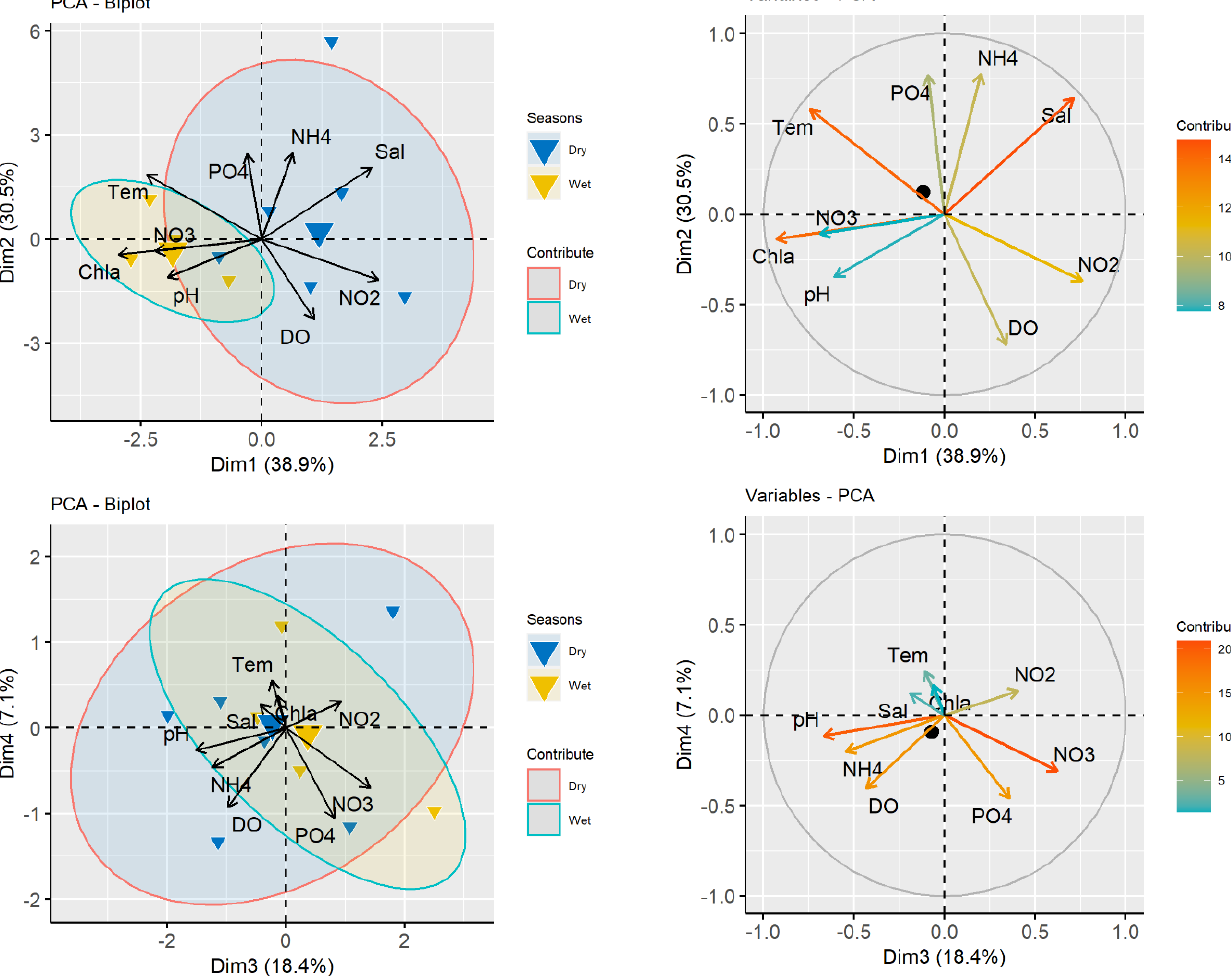
Figure 2. Principal component analysis (PCA) showed that water temperature, salinity and chlorophyll-a had a significant effect on fish distribution and assemblage composition. Cluster analysis grouped the nine water quality parameters (Temperature, NO 3 − , Chl-a, pH, PO 43 − , NH 4+ , salinity, NO 2 − and DO) and thirteen fish orders (Clupeiformes, Aulopiformes, Scombriformes, Gadiformes, Anguiliformes, Myliobatiformes, Gobiiformes, Siluriformes, Mugiliformes, Pleuronectiformes, Scorpaeniformes, Beloniformes, Synbranchi- formes, Anabantiformes, Perciformes and Decapoda) into two different clusters (Figure 3). The first cluster included temperature, NO 3 − , Chl-a and pH which showed their correlation with the rest of the parameters and the various fish orders. The second cluster included the thirteen fish orders and the rest of the parameters. The second cluster was divided into two subclasses, where the first subclass included all the fish orders and three water quality parameters salinity, PO 43 − and NH 4+ where the salinity was the dominant factor. The second subclass included a correlation of DO with the first subgroup (Figure 3). Overall, these findings suggest that water temperature, salinity and chlorophyll-a had a significant effect on the fish distribution and assemblage composition in the study area ( p <